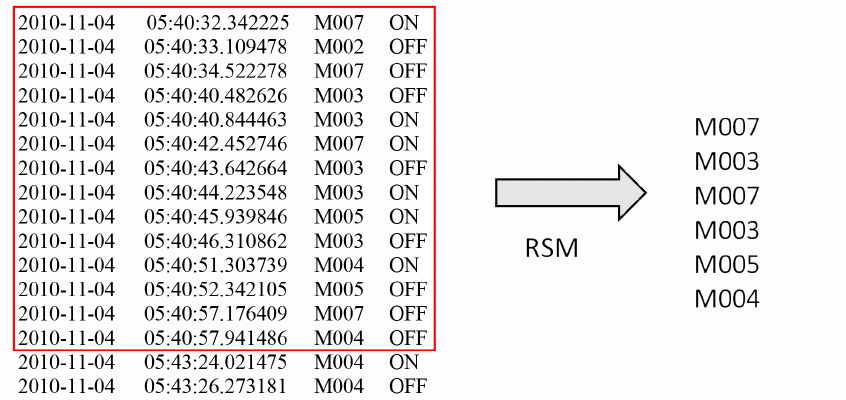
Figure 3. Raw sensor data and its RSM